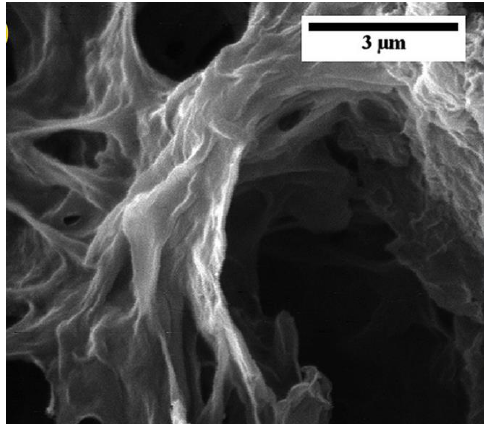
Figure 6. SEM image of 3D-structured nitrogen doped GO as reported by Ershadi et al. [86]. Reproduced, adapted and reprinted with permission from Reference [86] .